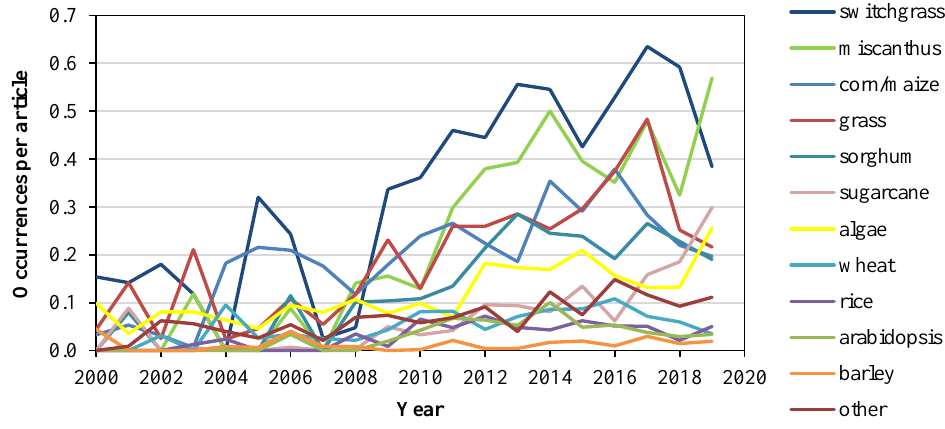
Figure 8. Trend chart of related terms in the “Crops” cluster.